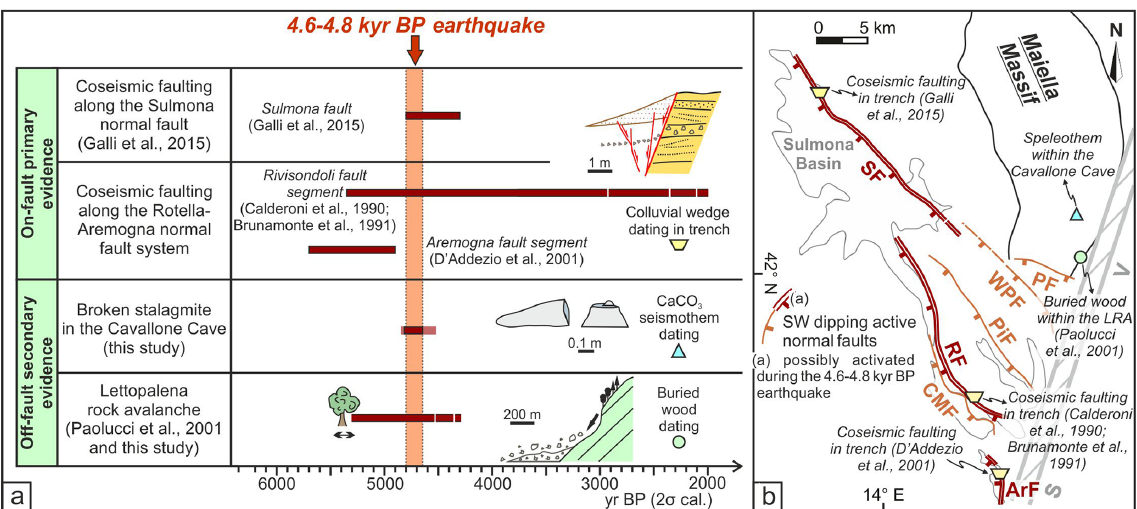
Figure 7. (a) Comparison between the ages resulting from radiocarbon dating of on-fault primary and off-fault secondary paleoseismic evidence recorded in the Maiella surroundings. One of the colluvial wedges that faulted along the Sulmona Fault reveals an earthquake within 4800–4300yrBP (Galli et al., 2015). Paleoevents with similar ages have also been recognized along the Rivisondoli and Aremogna fault segments belonging to the Rotella–Aremogna normal fault system (Calderoni et al., 1990; Brunamonte et al., 1991; D’Addezio et al., 2001). Dating performed in this study in the Cavallone Cave (light bar) on the broken stalagmite and the new re-growing one, overlap in the range included between 4815 and 4645yrBP (dark bar). The wood found within the Lettopalena rock avalanche predates the rock slide event which occurred after 5445–5300yrBP. This dating matches with around 4.6–4.8kyrBP, constraining the age of a mid-Holocene paleoearthquake. (b) Main SW-dipping active normal faults in the vicinity of Maiella. Symbols mark comparable ages (matching around 4.6– 4.8kyrBP) resulting from the dating of coseismic faulting along the Sulmona Fault (SF), the Rivisondoli Fault (RF) and Aremogna Fault (ArF) segments; the broken speleothem within the Cavallone Cave; and the Lettopalena rock avalanche (LRA). The synchronous activation of the Sulmona Fault with one or more normal fault segments to the south, could justify the large off-fault secondary effects recorded in the Maiella area (Cavallone Cave damages and Lettopalena rock avalanche). See the text for further explanation. PF: Palena Fault; WPF: western Porrara Fault; PiF: Pizzalto Fault; CMF: Cinque Miglia Fault; SV: Sangro–Volturno persistent structural barrier. PiF, RF, CMF and ArF all belong to the Rotella–Aremogna normal fault